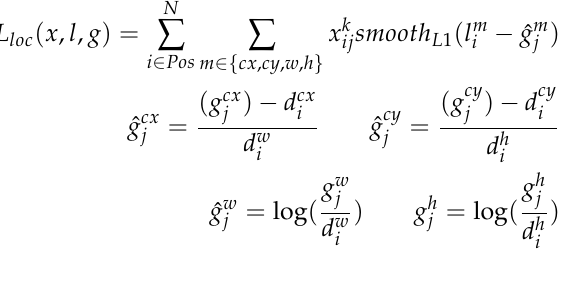
Figure 2. The detailed of multi-scale feature maps. Smooth L1 loss can avoid the gradient explosion caused by the wrong offset when the ground-truth and predicted box are too different. The L loc is defined in Equation (2). We regress to offsets for the center ( cx , cy ) of the default bounding box ( d ) and for its width ( w ) and height ( h ). The confidence loss is defined in Equation